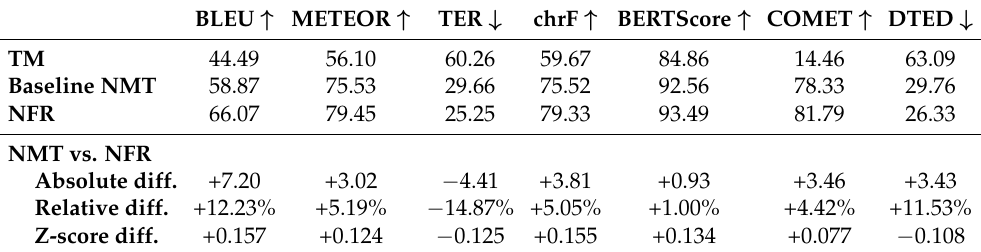
Table 6. Automatic evaluation results for TM, baseline NMT and NFR. Arrows next to each metric indicate that either higher scores ( ↑ ) or lower scores ( ↓ ) are better. Scores are reported per system, absolute and relative difference between baseline and NFR and difference in terms of standard (z) scores. BLEU ↑ METEOR ↑ TER ↓